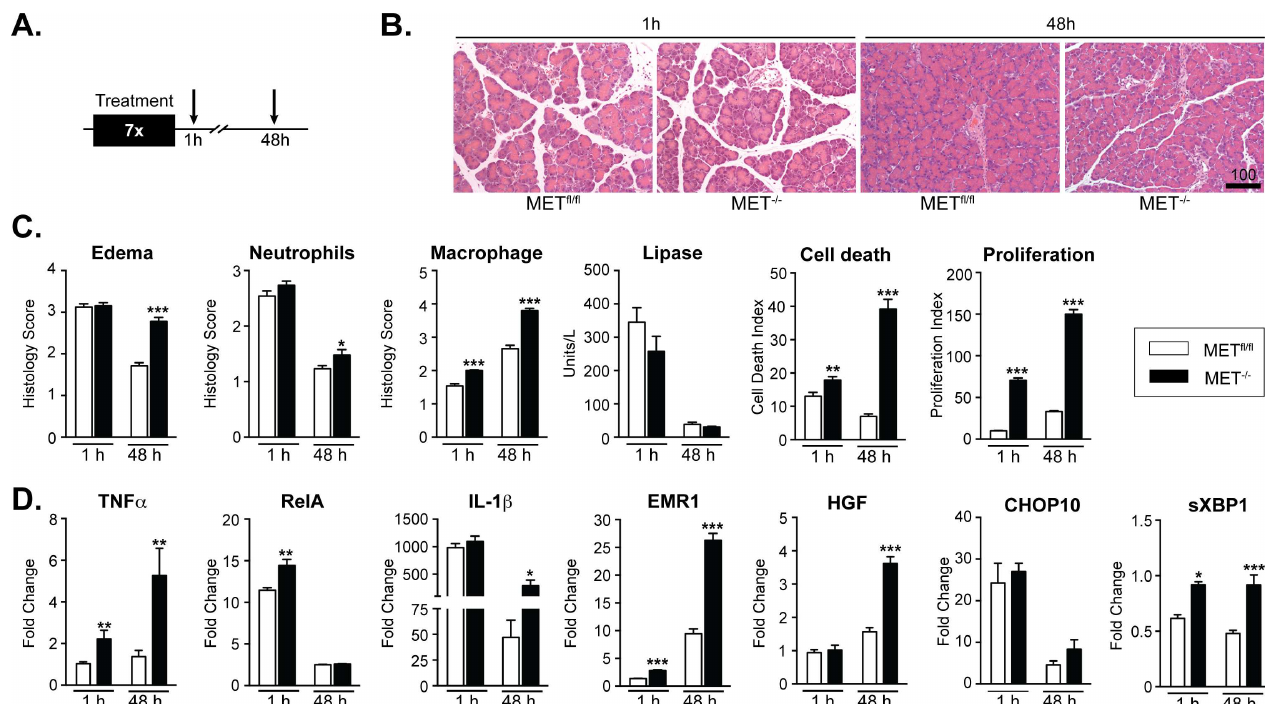
Fig 4. Genetic deletion of MET in acinar cells increased the severity of acute cerulein-induced injury. A, ceruleinor saline treated MET fl/fl and MET -/- mice were sacrificed 1 h or 48 h followingthe last treatment. B, Representative H&E stained pancreatic sections, 1h and 48h following ceruleintreatments are shown (Scale, microns). C, Morphometric analysesof edema, neutrophil and macrophageinfiltration, acinar cell death and proliferation, and serum lipase levels are presented as mean ± SEM values from 4–5 mice per time point (multiple t -test, * , p < 0.05; ** , p < 0.01; *** , p < 0.001). D, qRT-PCR confirmed relative changes in transcript levels in cerulein treated MET fl/fl and MET -/- mice for mediators of inflammation TNF α , RelA, Il-1 β , macrophages (EMR1), HGF and ER stress markers (CHOP10 and sXBP1) (multiple t-test, * , p < 0.05; ** , p < 0.01; *** , p < 0.001).